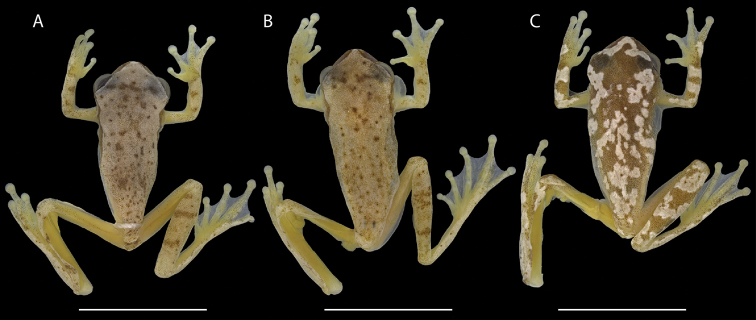
Preserved males of Dendropsophus
bilobatus sp. nov. in dorsal view showing color variation. AINPA-H 41302, SVL = 19.4 mm BINPA-H 41304, SVL = 20.1 mm CINPA-H 41306, SVL = 20.8 mm. Scale bars: 10 mm. Photographs: Jeni Lima Magnusson.